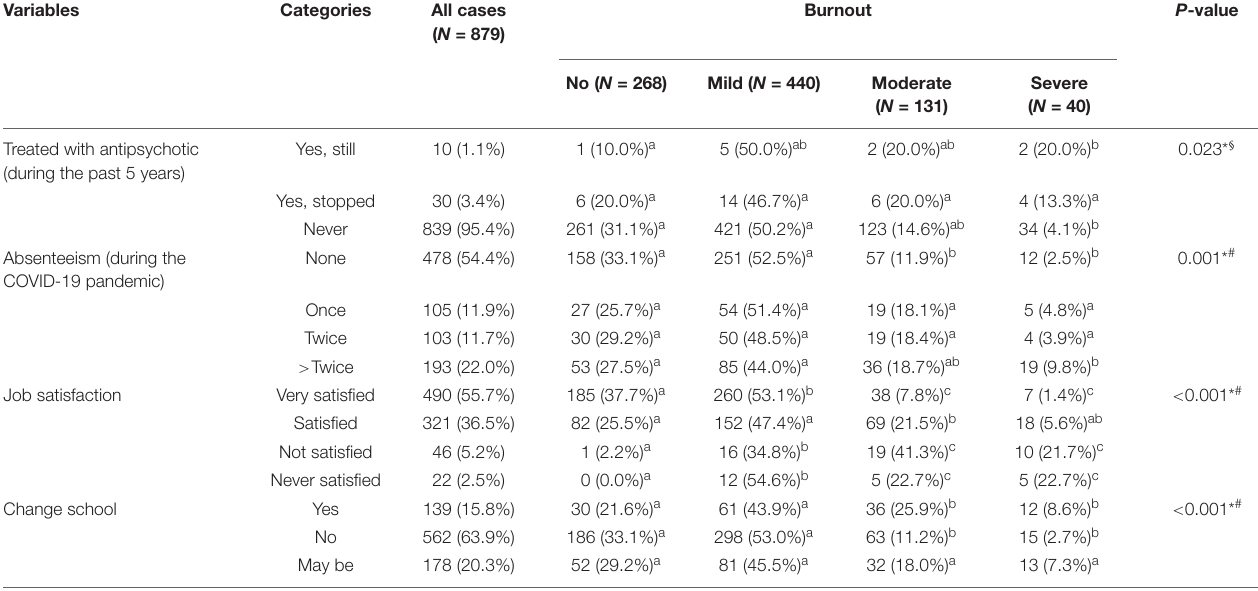
TABLE 2 | Consequences of burnout among teachers considering its severity.